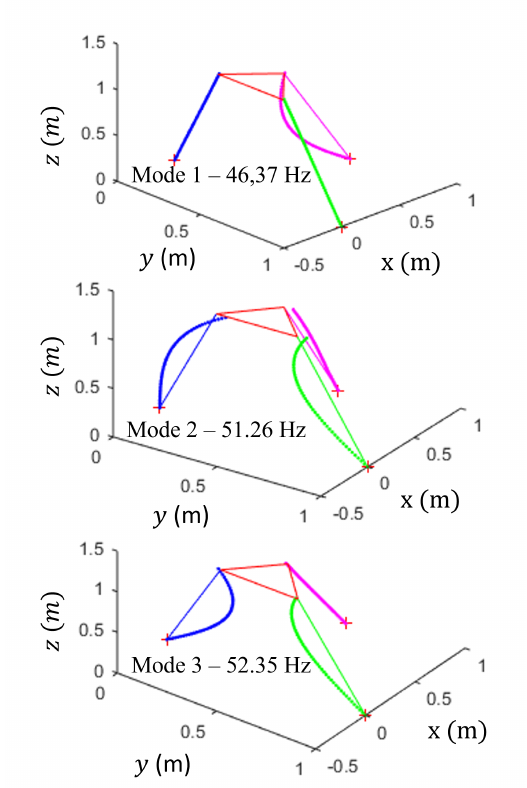
Figure 11. Modal shapes associated with the first tree natural frequencies of Tripteor X7.